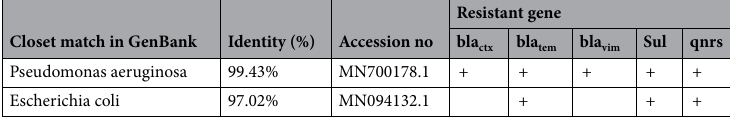
Table 1. Sequence-based identification of hospital wastewater bacteria by BLAST.